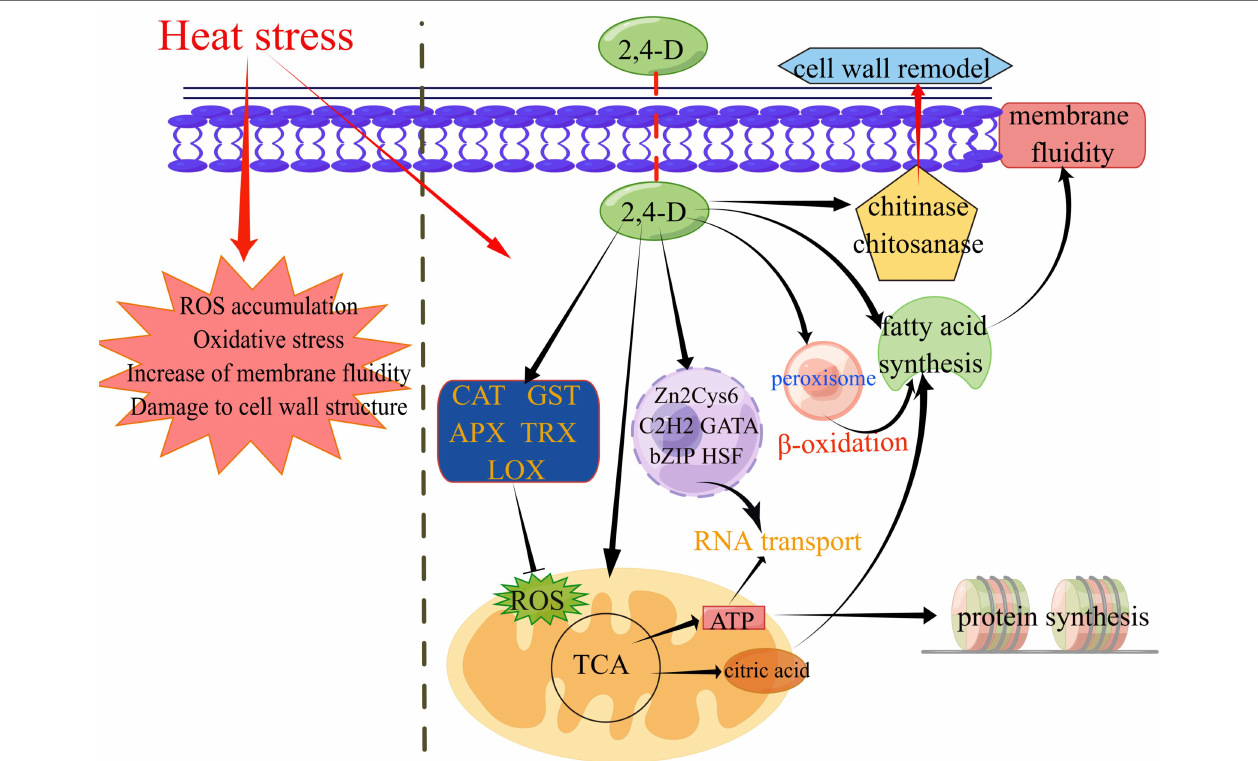
FIGURE 5 | A proposed working model for the molecular mechanism of 2,4-D in enhancing L. edodes thermotolerance. This graph was generated by figdraw